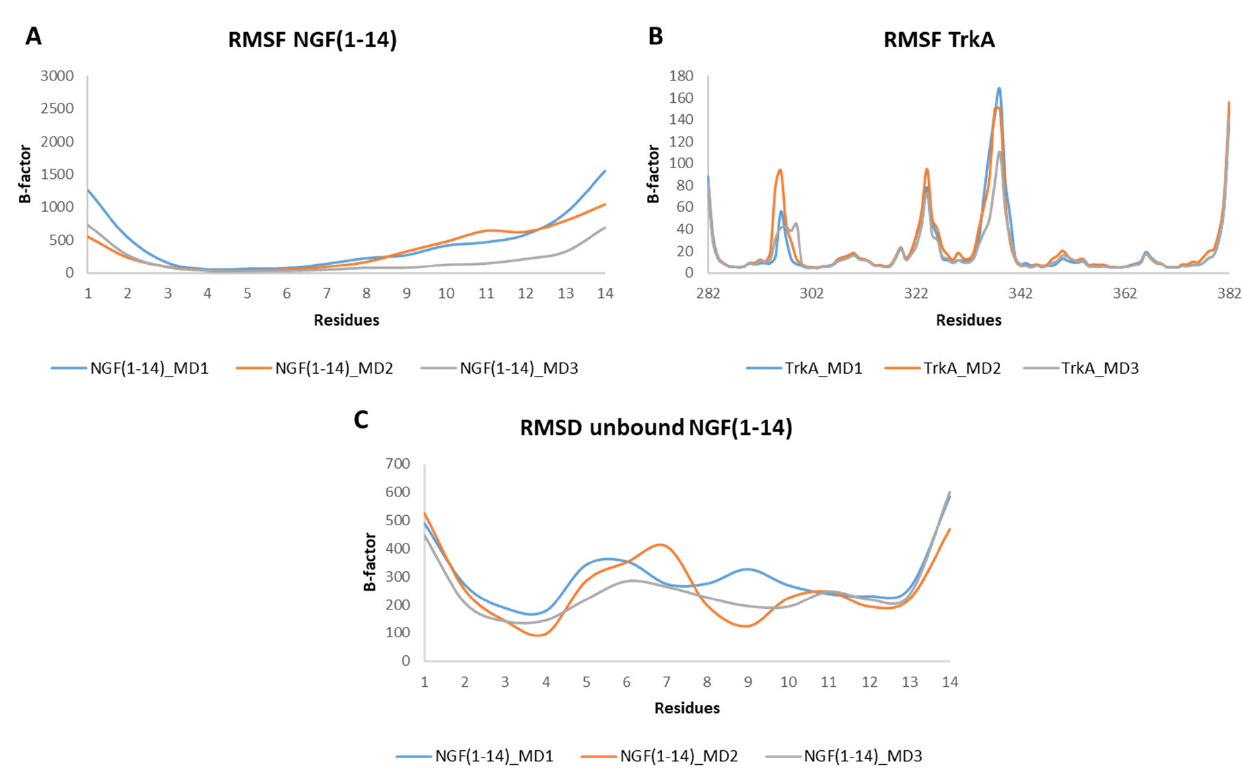
Figure 7. RMSF plots of the backbones of NGF(1–14) ( A ) and TrkA ( B ) registered during the three MD runs performed on NGF(1–14)-TrkA complex. ( C ) RMSF profiles of NGF(1–14) backbone. Per-residue energy decomposition was carried out on each MD run of the NGF(1–14)- TrkA complex and the results were averaged. The outcomes revealed that His4, Ile6 and Arg9 furnished the most significant contribution to the binding free energy (Figure S6) with mean ∆ G values lower than − 3 Kcal/mol, thus confirming the results gained for the full-length NGF in